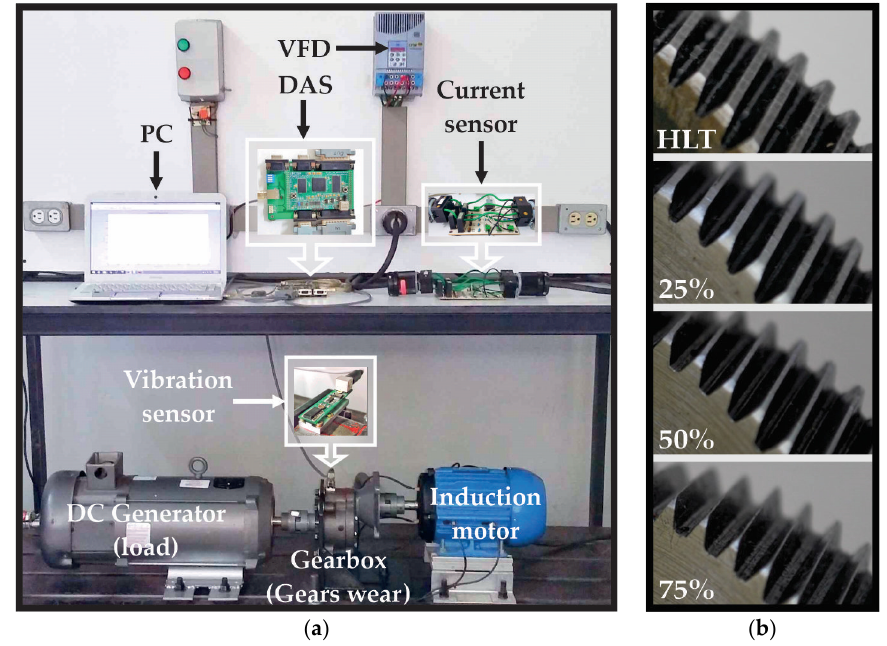
Figure 5. Experimental setup, in ( a ) Physical system, and ( b ) Gears with gradual wear.